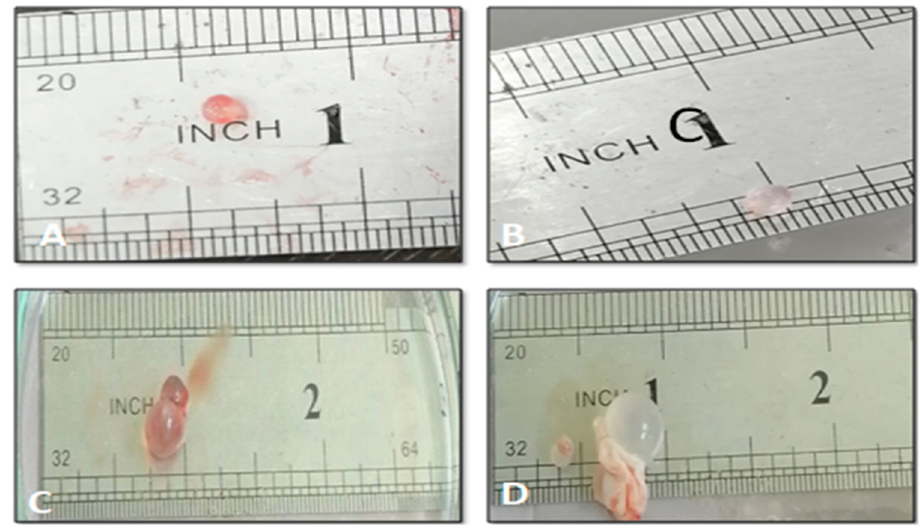
Figure 8. Hydatid cysts isolated from the experimentally infected untreated mice ( A , C ), and infected treated mice ( B , D ).